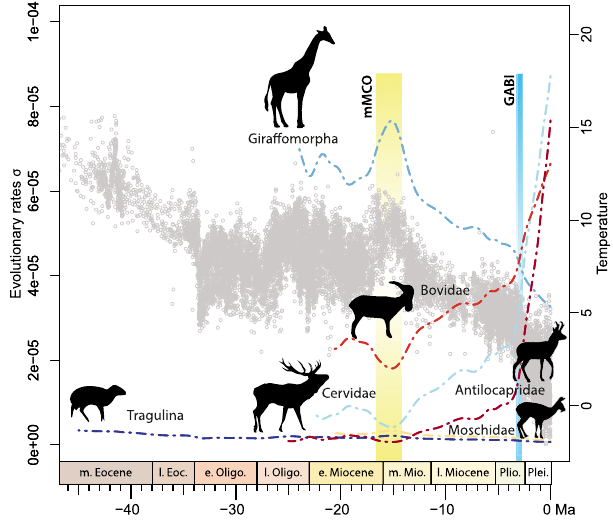
Fig. 3 | Evolutionary rates of the different ruminant families ’ bony labyrinth morphologybasedonPCscorescomparedwiththeglobaltemperaturecurve 1 (gray dots). The Middle Miocene Climatic Optimum (mMCO) and the Great American Biotic Interchange (GABI) are highlighted since they are important fac- torsintheruminantevolution.Methodologyandstatisticalresultsproducedbythe R package RPanda 93 are provided in Material and Methods and Supplementary Data 1. Groups are Tragulina (dark blue; Stem Ruminantia+Tragulidae), Antiloca- pridae(darkred),Giraffomorpha(darklightblue),Cervidae(lightblue),Moschidae (yellow), Bovidae (red). Silhouettes of the families modi fi ed from 107